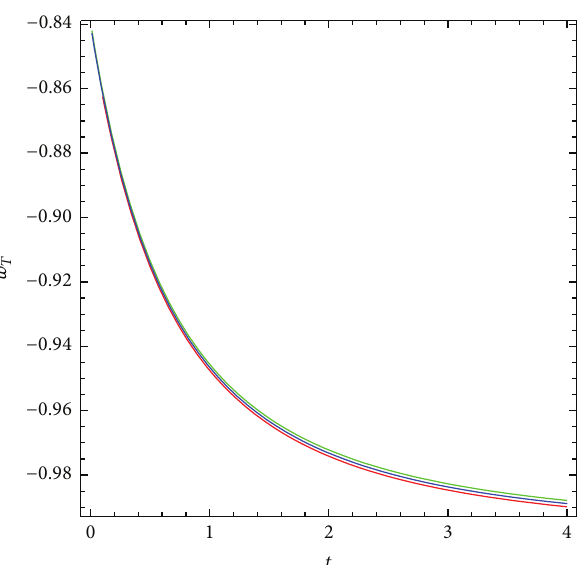
Figure 2: Effective torsion EoS parameter as in (36).